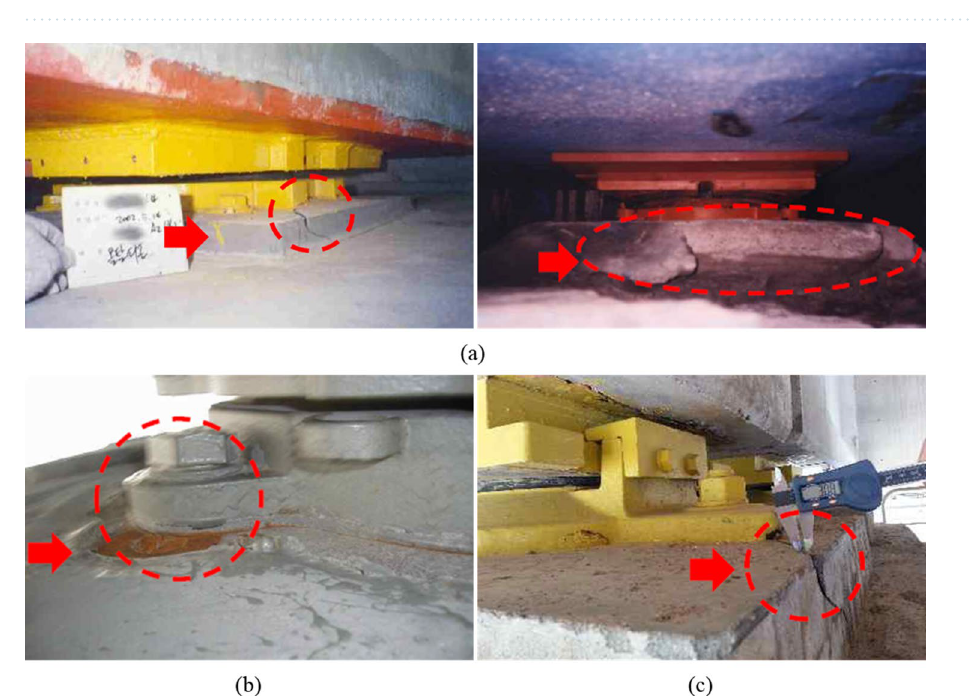
Figure 2. Damage types of bridge bearing anchors: ( a ) damage to the grout bedding, ( b ) failure of anchor bolt, ( c ) breakout failure of concrete